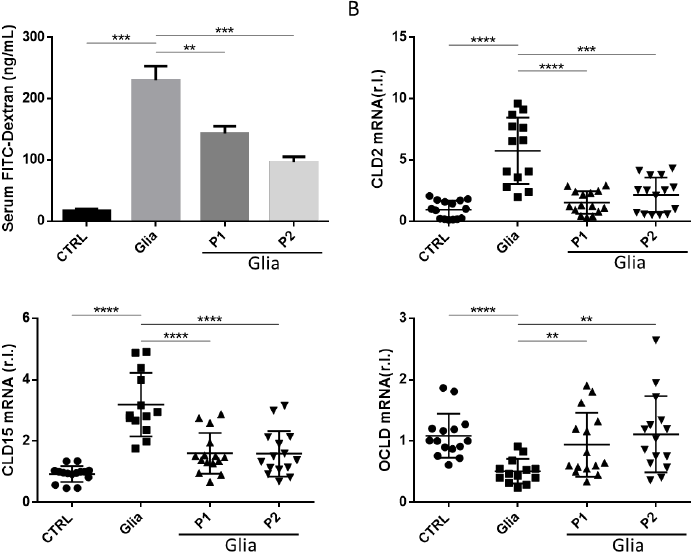
Figure 2. Gliadin-mediated intestinal permeability dysregulation is restored by probiotics admin- istration. Plasma concentration of fluorescein isothiocyanate-conjugated (FITC) fluorescence was measured 4 h after mouse gavage of a single dose of FITC-Dextran ( A ). Quantification of plasma concentration from n = 2 mice per group. Mean ± SD of duplicate sample. ( B ) Claudin 2 (upper panel), Claudin 15 (bottom left panel), and Occludin (bottom right panel) expression levels were evaluated in the small intestine of third-generation Balb/c mice fed with gluten-free diet chal- lenged with gliadin (Glia) in the presence or absence of P1 or P2 by quantitative real-time poly- merase chain reaction (qRT-PCR). Mean ± SD of triplicate sample; **** p < 0.0001; *** p < 0.001; ** p < 0.01.